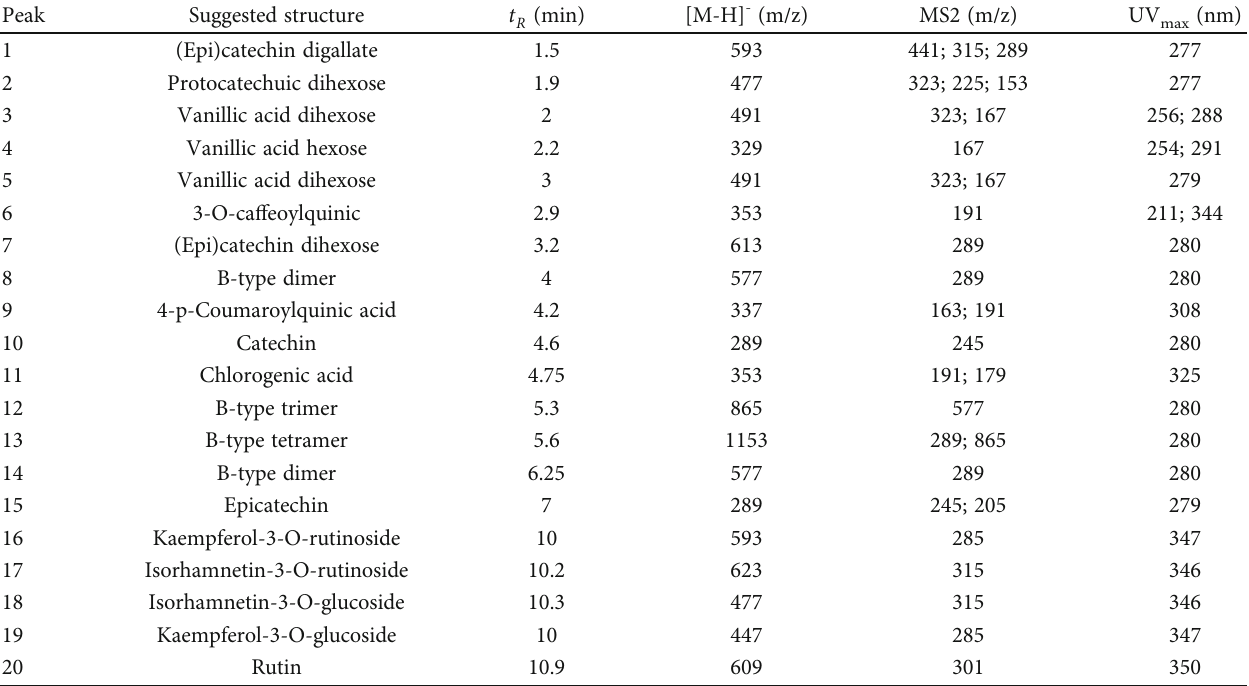
Table 2: Phenolic compounds identi fi ed by UPLC-DAD/ESI-MSn in almond skin extracts.